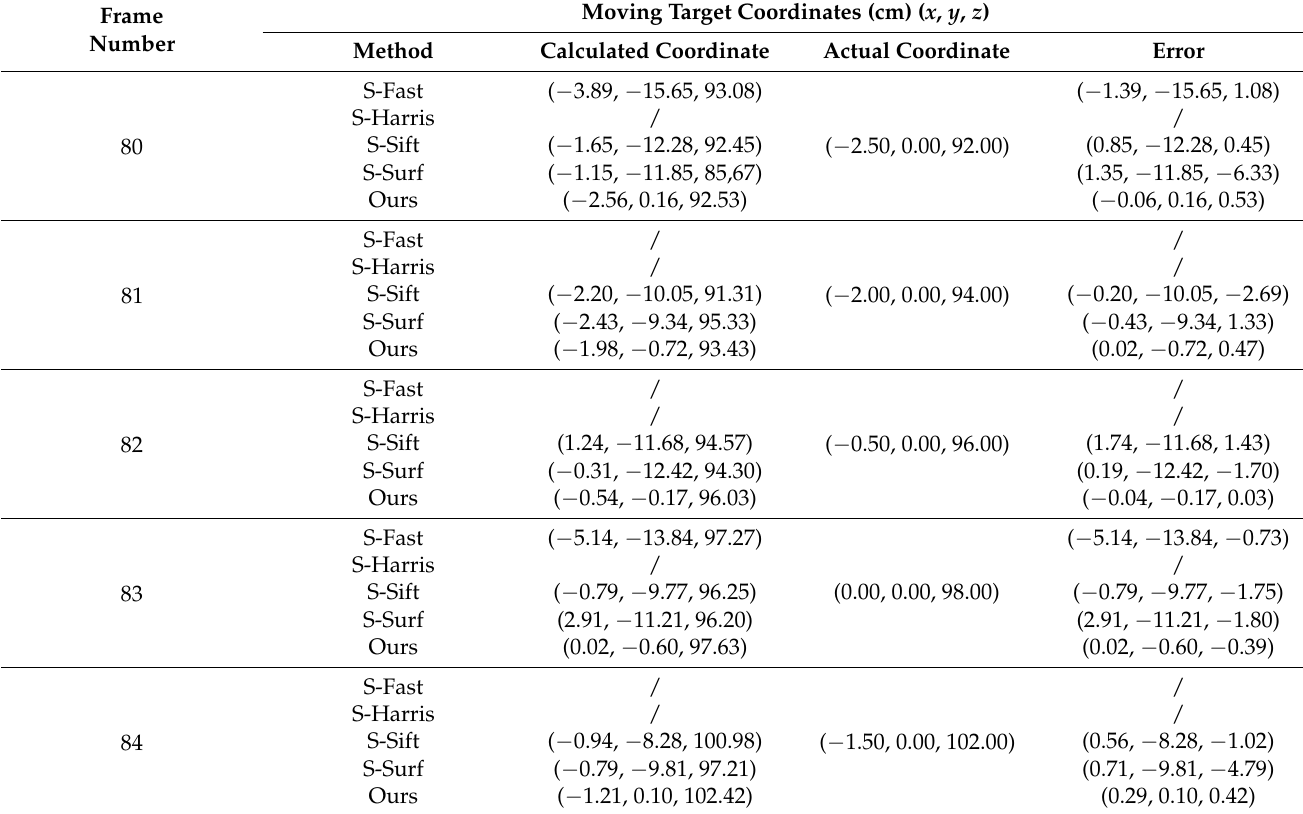
Table 3. The experimental results of the three-dimensional coordinates of the moving objects and error comparison.